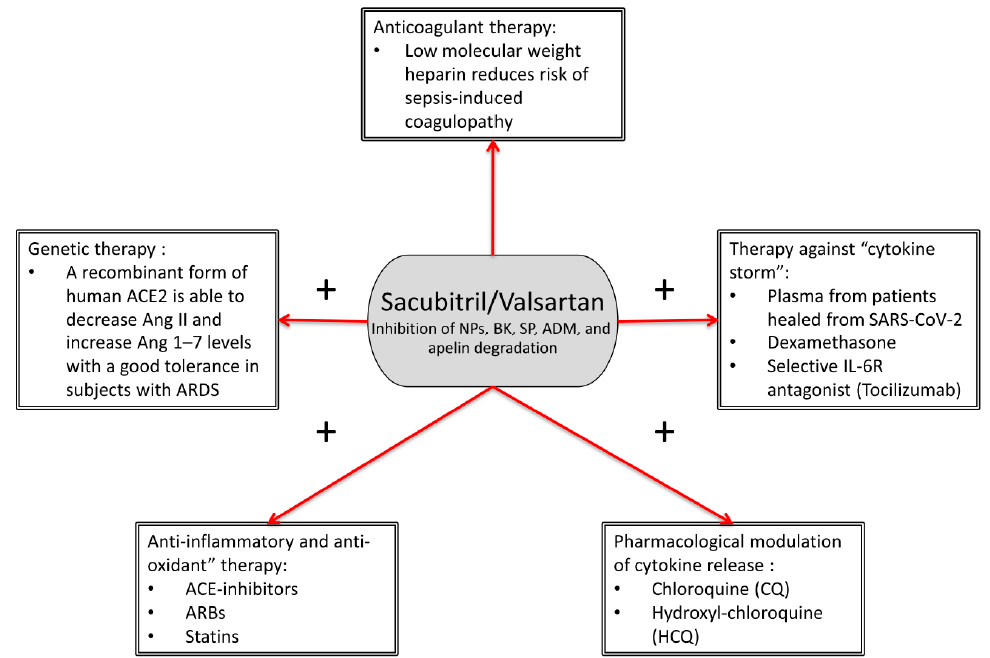
Figure 3. Sacubitril/valsartan (SAC/VAL) in a “multi-targeted” therapeutic strategy for COVID-19. SAC/VAL could have potential relevant synergistic effects with most of drugs commonly used in infection. Sign “+” indicates pharmacological associations with potential synergistic effects. NPs: natriuretic peptides; BK: bradykinin; SP: substance P; ADM: adrenomedullin; ARBs: